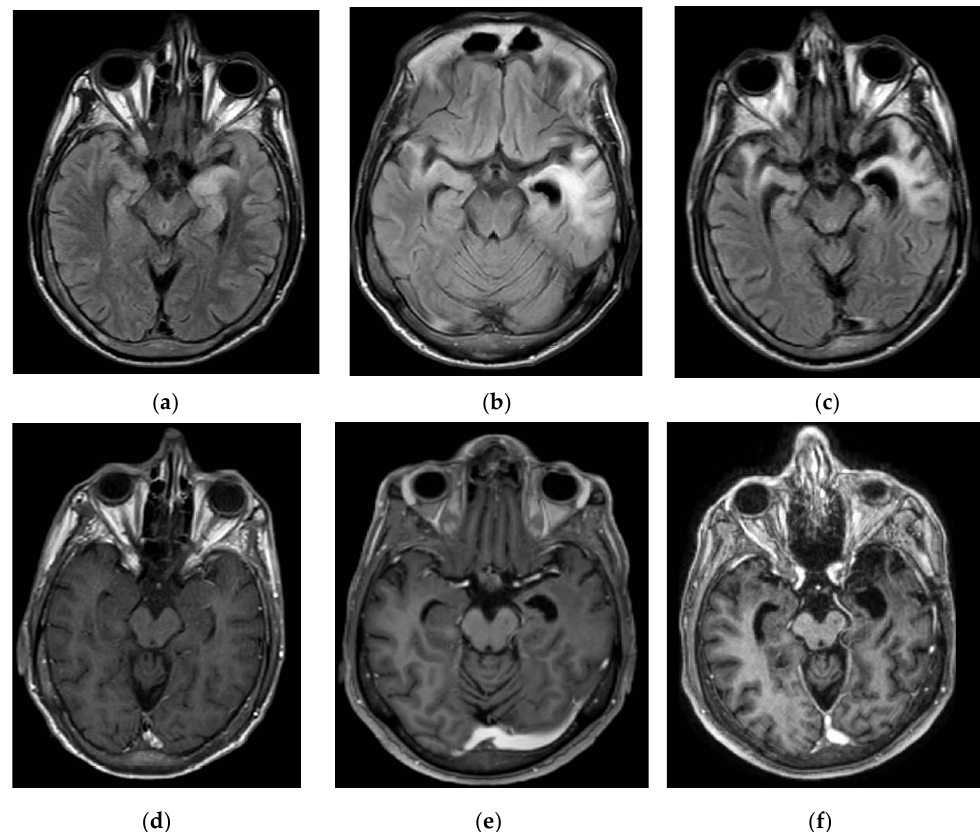
Figure 1. Neuroimaging: ( a ) FLAIR hyperintensity and swelling in bilateral hippocampi and temporal lobes; ( b , c ) Progressive worsening of FLAIR hyperintensities with associated atrophy at second and third admissions, respectively; ( d ) T1 hypointensities in bilateral hippocampi with subtle contrast enhancement; ( e , f ) Progressive worsening of T1 hypointensities without any contrast enhancement, with associated atrophy at second and third admissions, respectively.